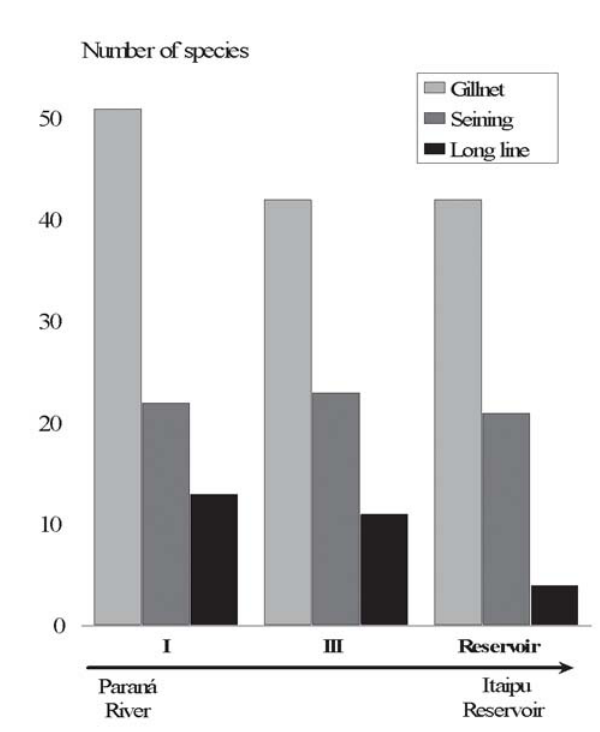
Fig. 5. Number of species sampled with the same fishing gear in the segments I, III, and